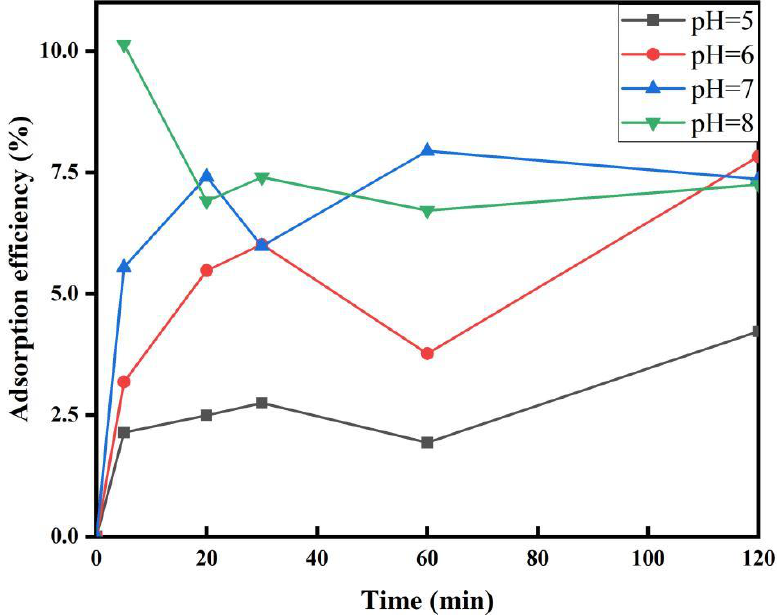
Figure 2. Effect of pH on the sorption of Sr on soil colloids. T = 25 ± 1 ◦ C, C[Sr 2+ ] initial = 100 mg · L − 1 , soil-liquid rate = 800 mg · L − 1